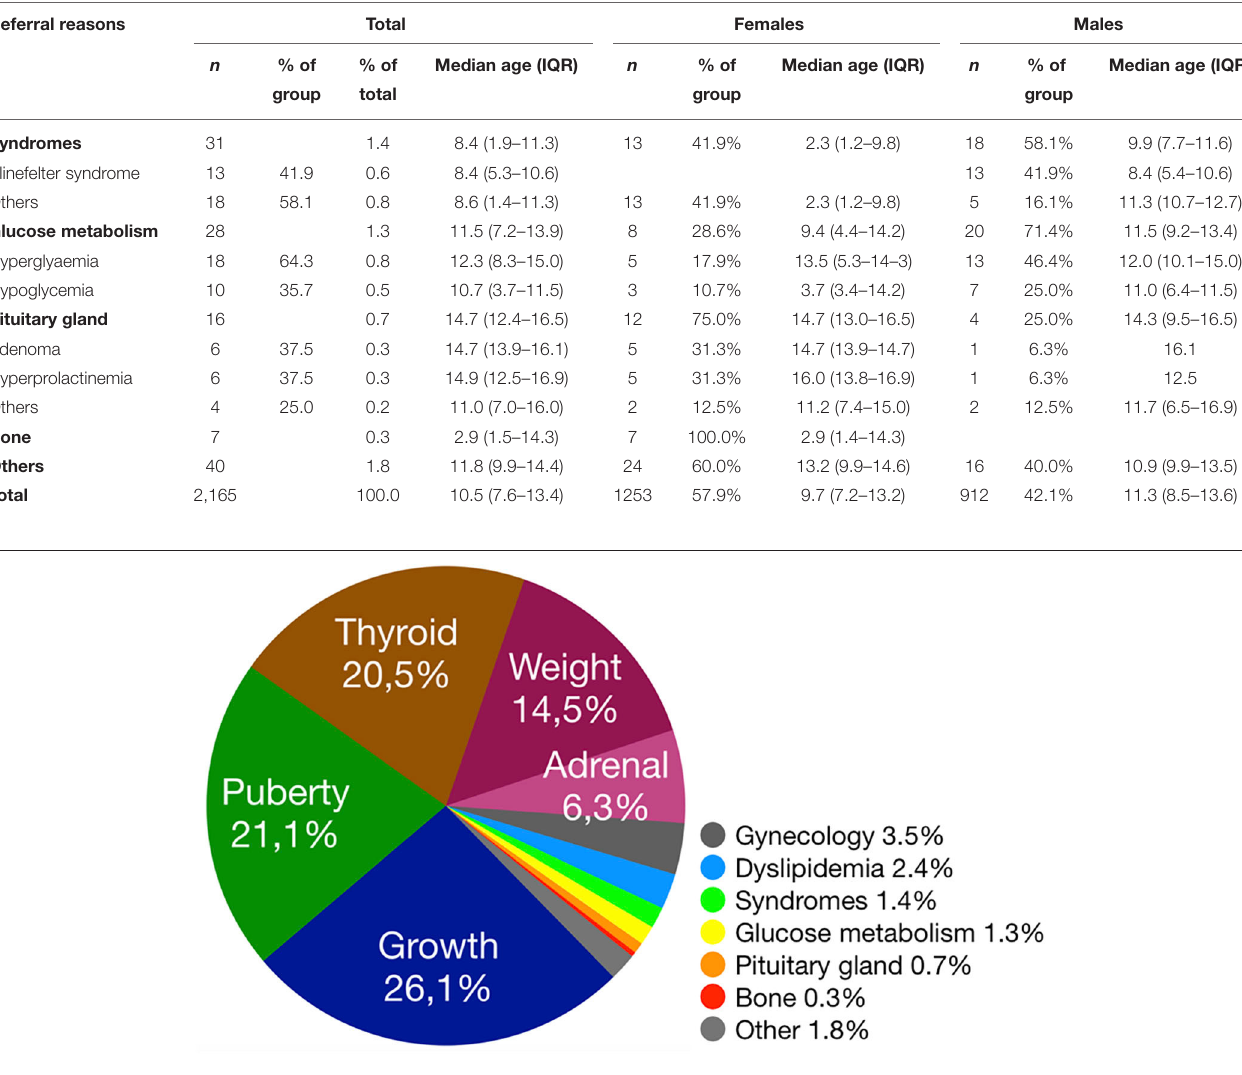
The age at referral was significantly higher in “planned”